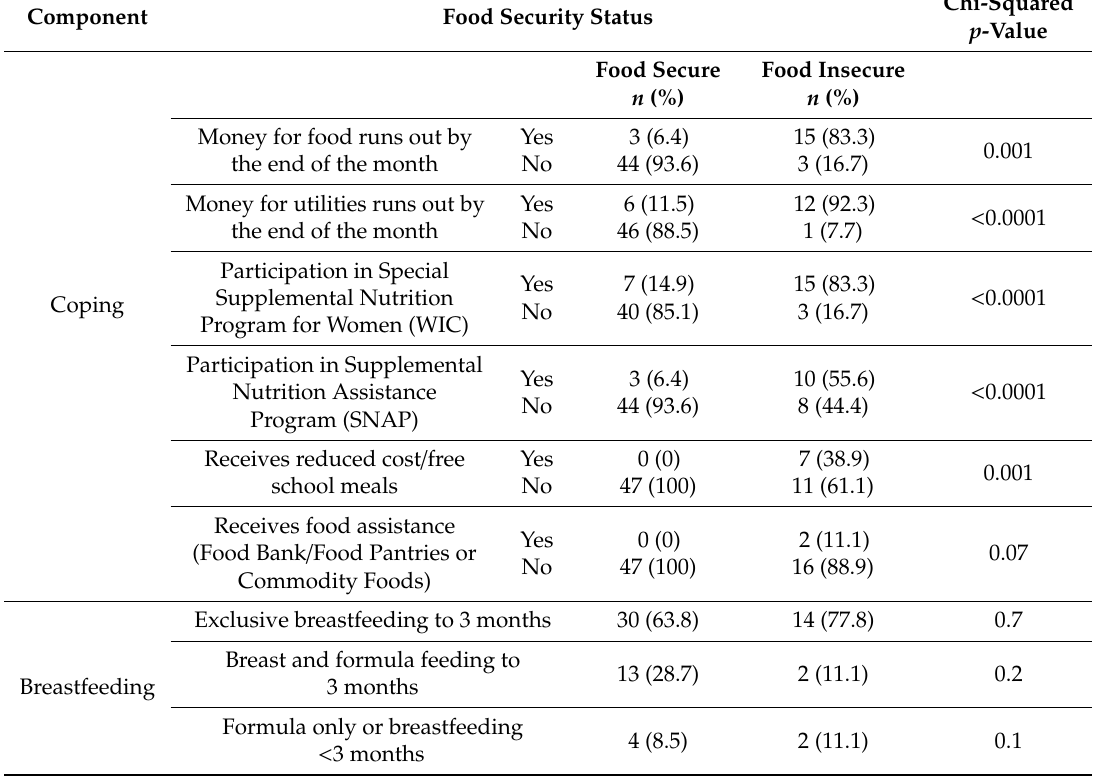
Table 4. Proportion of infants aged 3–12 months enrolled in the cross-sectional study classified as food secure or insecure by each component of the adapted infant food security index used in this study ( n = 70) a,b